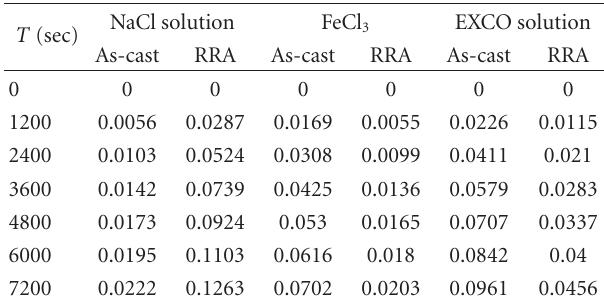
Table 8: Gravimetric corrosion rate (mm/yr) for the control specimen.